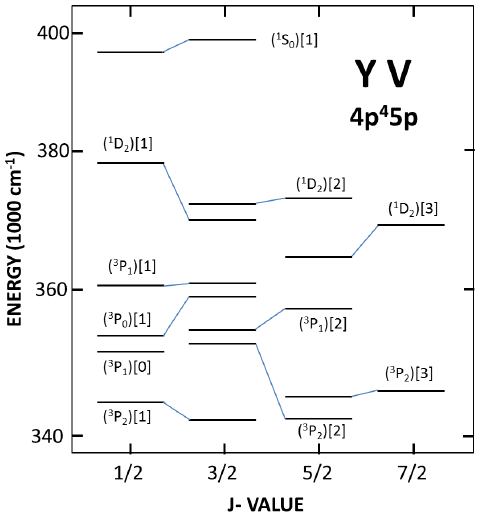
Figure 4. Structure of the 4s 2 4p 4 5p configuration of Y V.